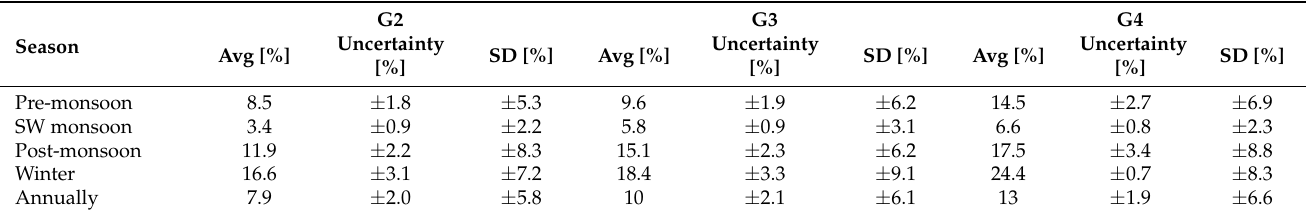
Figure 5. Frequency distribution of the average relative direct transmittance of the weekly cleaned (G2), monthly cleaned (G3), and never cleaned (G4) glass coupons over the year. Table 1. The seasonal and annual average (Avg) transmittance loss ( τ loss in %), seasonal average uncertainty (%), and seasonal average standard deviation (SD in %) in the average relative direct transmittance ( τ r ) of different glass coupons. The average relative direct transmittance is the average for measurements taken at three spots of the glass coupon over the wavelength 350-1000 nm.